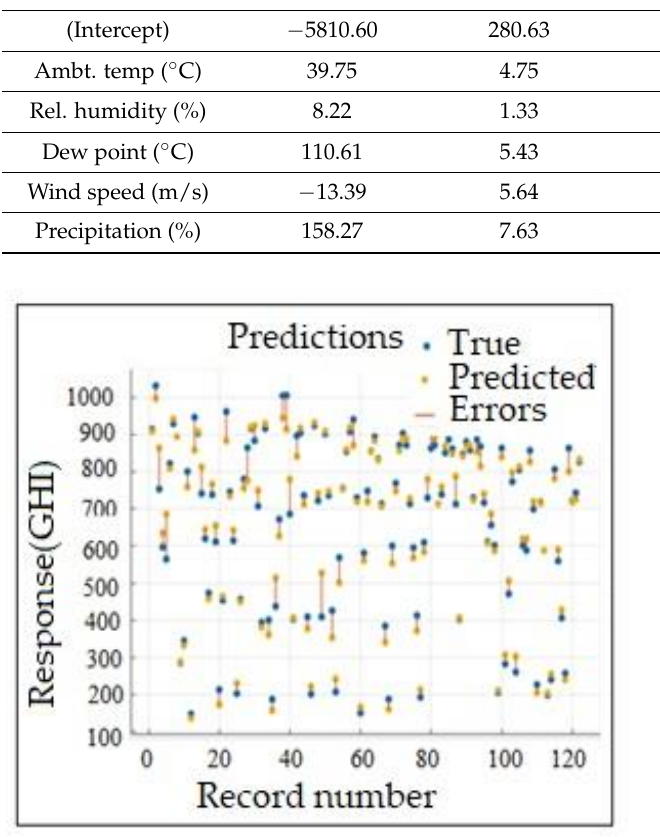
Figure 4. Prediction plot for irradiance, obtained from linear regression analysis. The mathematical function model is shown in (7).